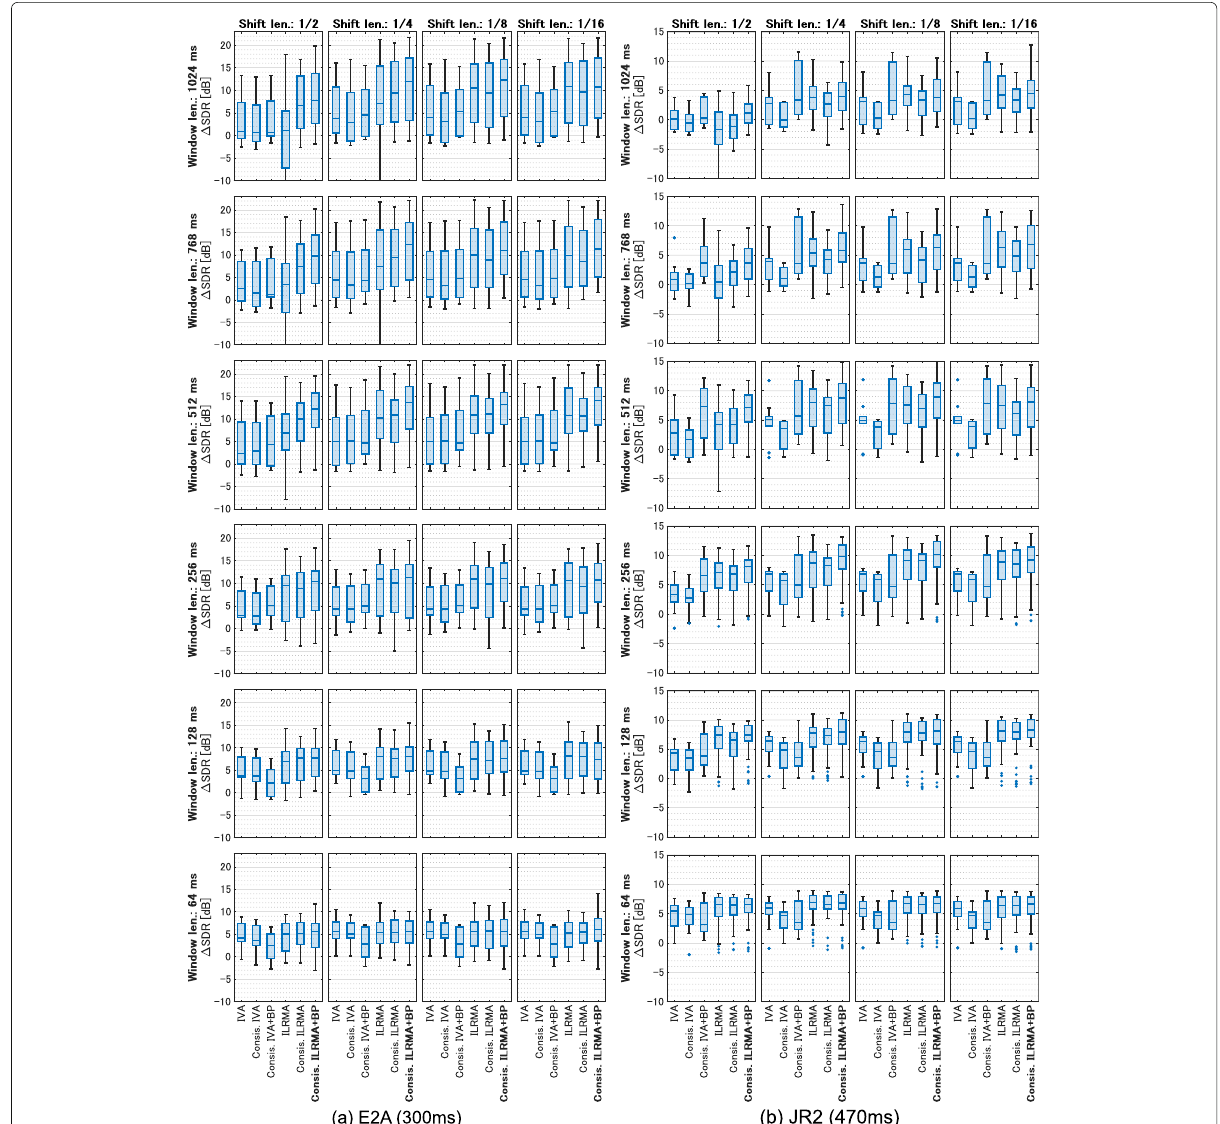
Fig. 13 Average SDR improvements for synthesized music mixtures (music 1–10) with a E2A and b JR2 , where Blackman window is used in